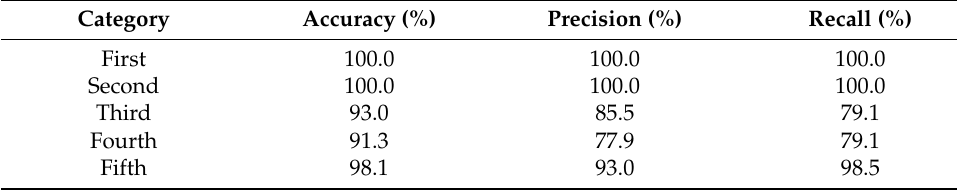
Table 3. The classification results for O-F-ResNet (Fusion